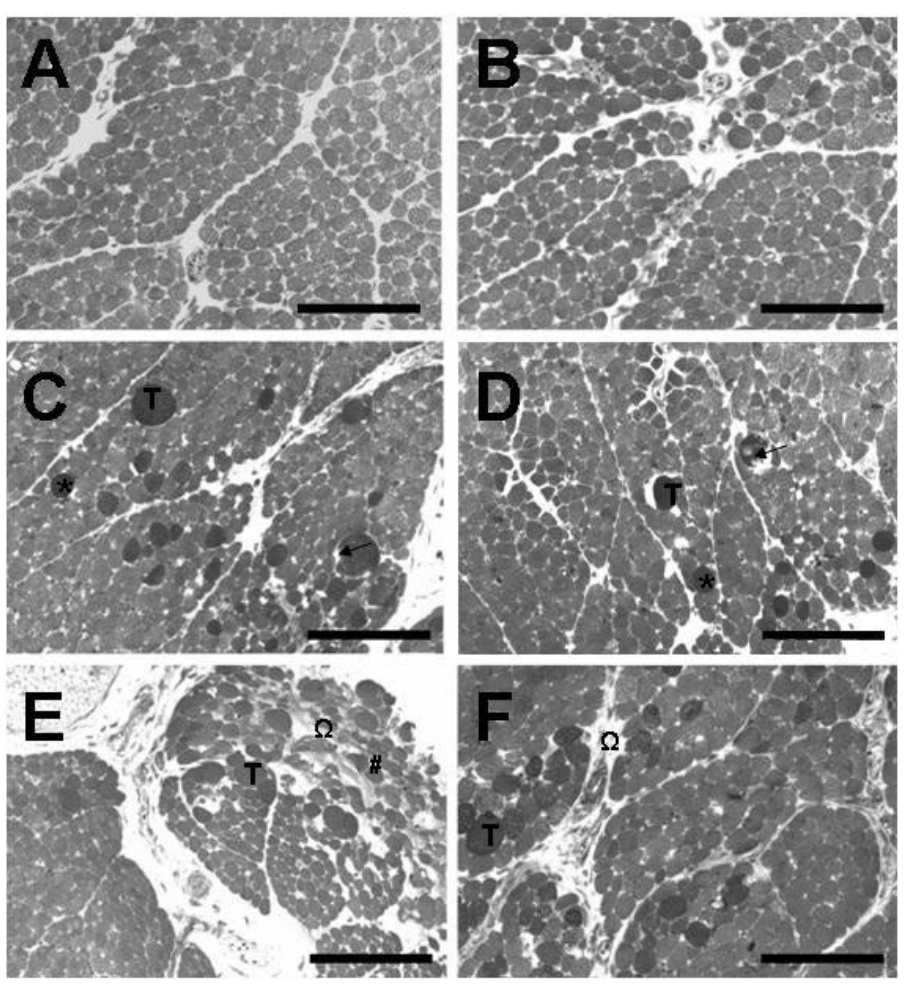
Figure 4. Cross-sections (2 μ m thick) of chick biventer cervicis preparations